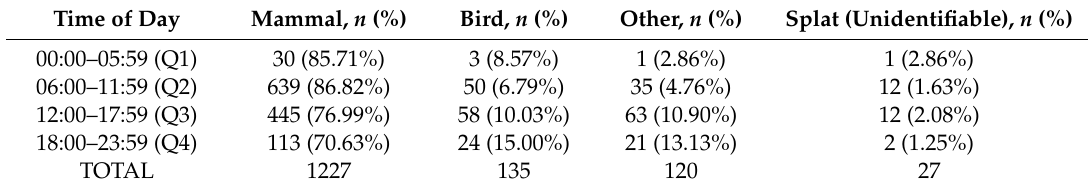
Table 2. Taxonomic class of 1509 roadkill reports from RRApp users according to the local quadrant of day of the report.